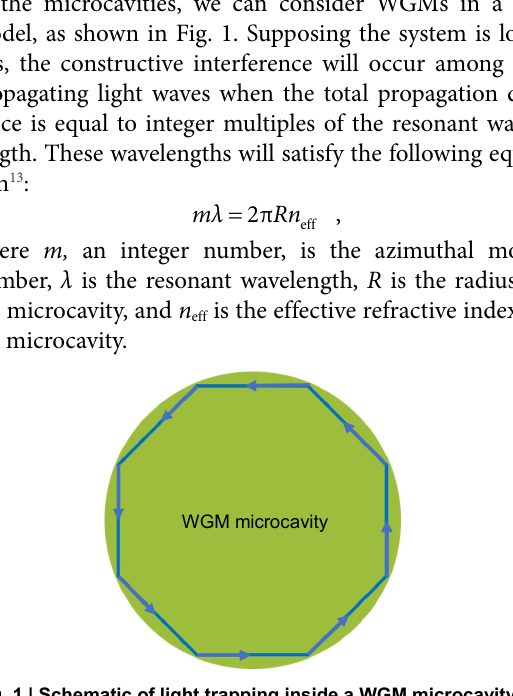
Fig. 1 | Schematic of light trapping inside a WGM microcavity by frustrated total internal